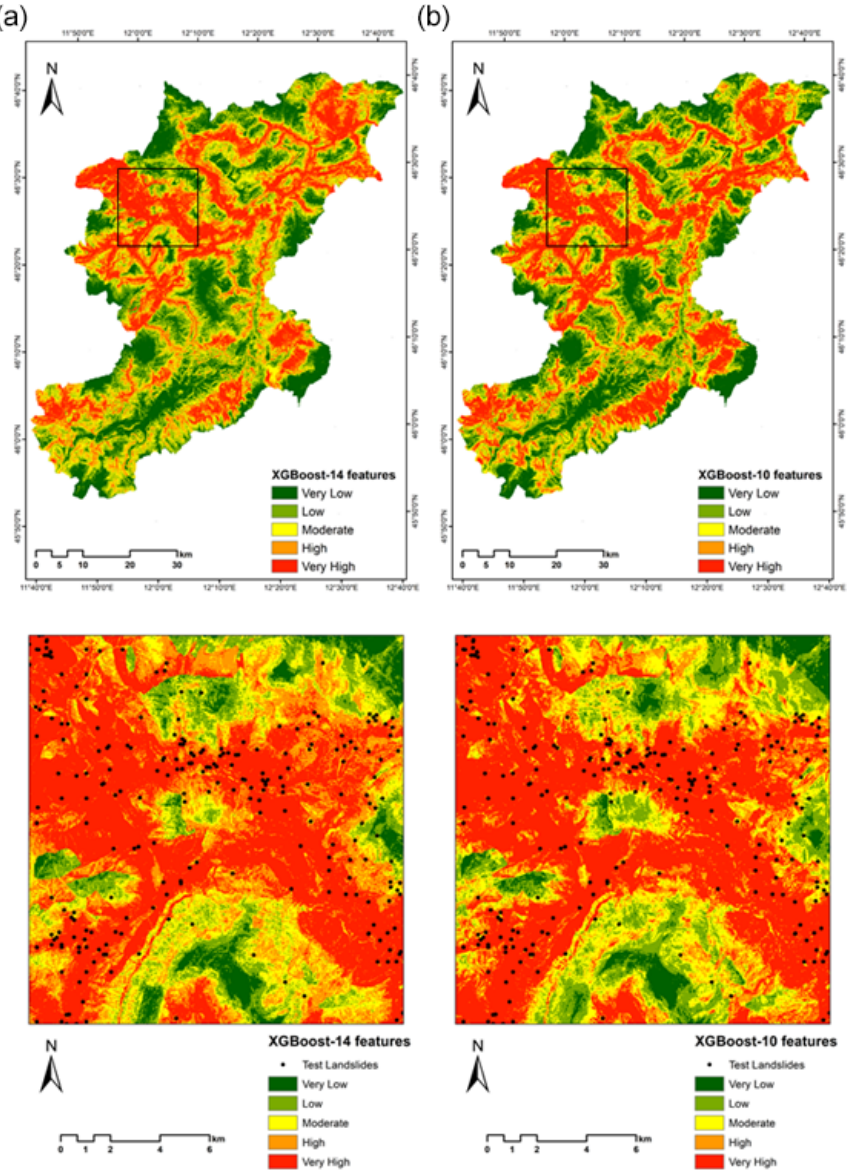
Figure 9. LSMs derived using the XGBoost approach for (a) 14 landslide features and (b) 9 landslide features (black square represents the enlarged